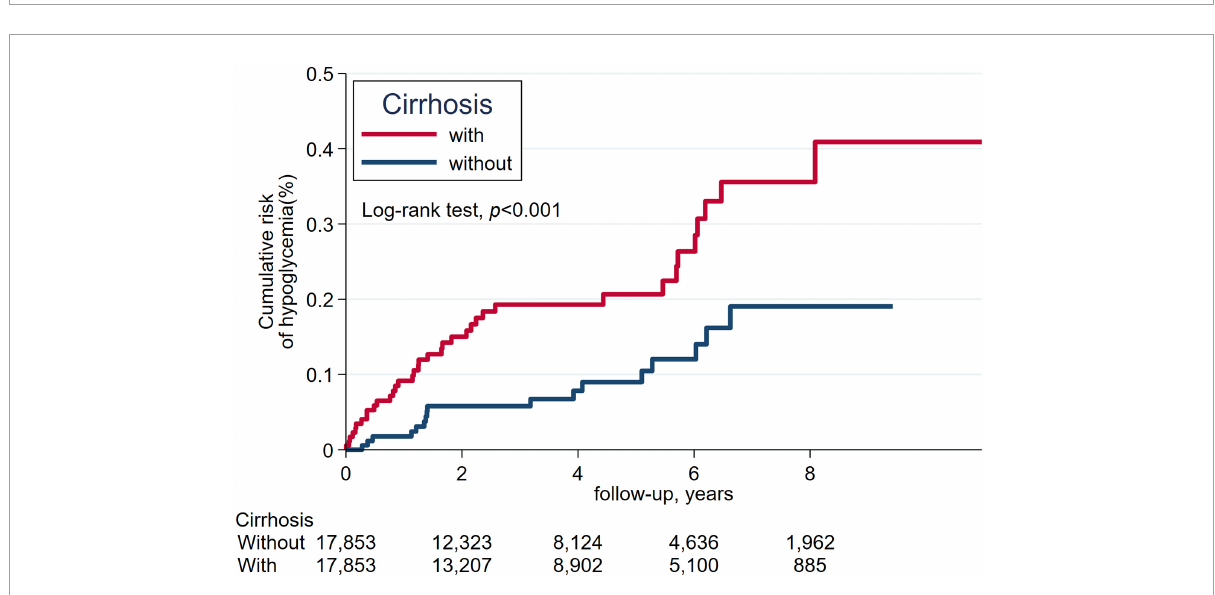
FIGURE3 The cumulative incidence of severe hypoglycemia between patients with cirrhosis and without